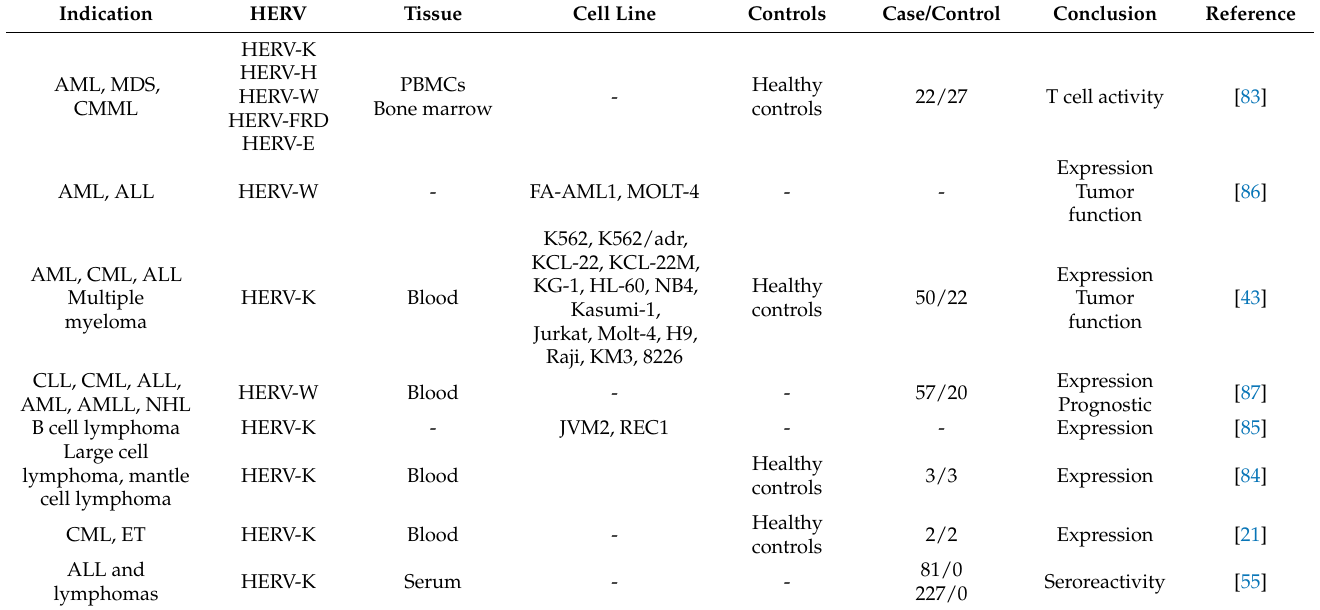
Table 4. HERV protein expression in hematological